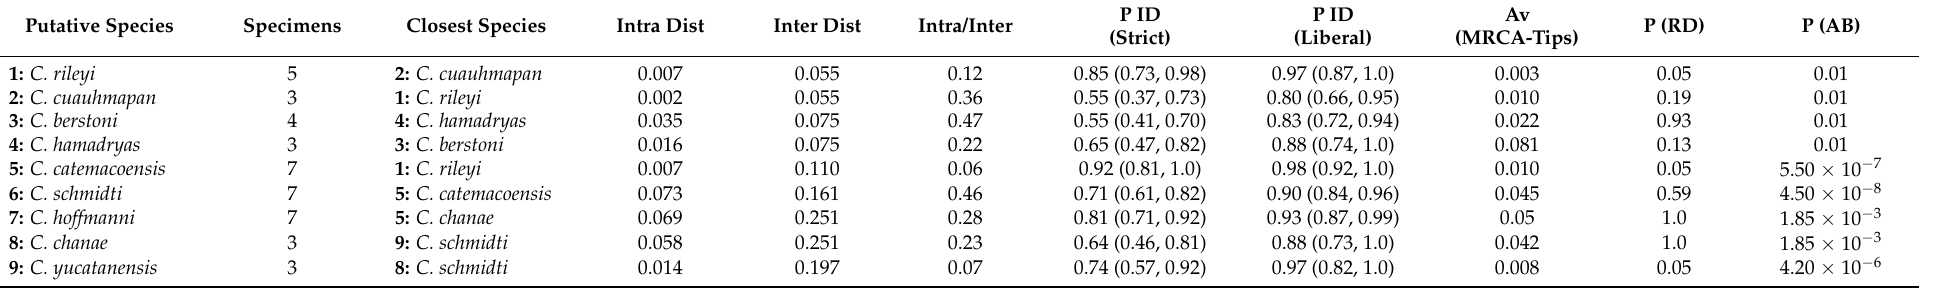
Table 2. Genetic distances and species delimitation metrics among and within species of the arboreal Neotropical ‘ thorellii ’ clade of Centruroides Marx, 1890 bark scorpions (Buthidae C.L. Koch 1837). Definitions modified from Masters et al. (2011): Intra Dist: average pairwise tree distance among species; Inter Dist: average pairwise tree distance within species; Intra/Inter: ratio of Intra Dist to Inter Dist; P ID (Strict): mean probability, with 95% confidence interval (CI), of correct identification of unknown specimen using placement on tree; P ID (Liberal): mean probability, with 95% confidence interval (CI), of correct identification of unknown specimen using BLAST (best sequence alignment), DNA Barcoding (closest genetic distance), or placement on tree; Av (MRCA-tips): mean distance between most recent common ancestor of species and its conspecific members; P (RD): probability that clades have observed degree of distinctiveness; P (AB): probability that clades are reciprocally